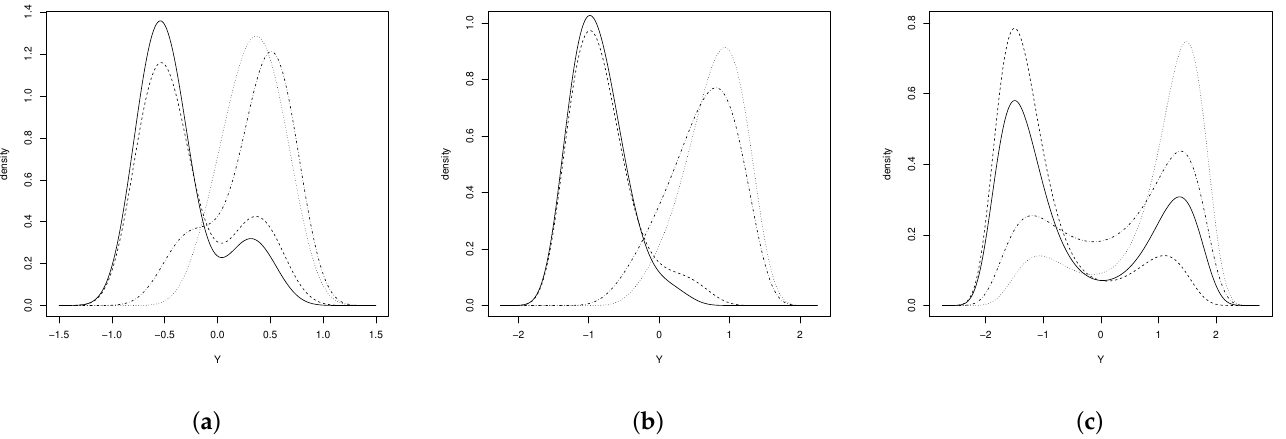
Figure 2. EGSHN distribution ( a ) ESHN ( 0.75,0,1,3.5, − 0.75 ) (solid line), ESHN ( 0.75,0,1,2.5, − 0.5 ) (dashed line), ESHN ( 0.75,0,1,0.5,1.5 ) (dotted line) and ESHN ( 0.75,0,1,1.5,0.75 ) (dash-dotted line), ( b ) ESHN ( 1.5,0,1,3.5, − 2.5 ) (solid line), ESHN ( 1.5,0,1,2.5, − 1.5 ) (dashed line), ESHN ( 1.5,0,1,1.5,2.5 ) (dotted line) and ESHN ( 1.5,0,1,0.5,1.5 ) (dash-dotted line) and ( c ) ESHN ( 2.5,0,1,3.5, − 0.25 ) (solid line), ESHN ( 2.5,0,1,3.5, − 0.75 ) (dashed line), ESHN ( 2.5,0,1,2.5,0.75 ) (dot- ted line) and ESHN ( 2.5,0,1,0.75,0.25 ) (dash-dotted